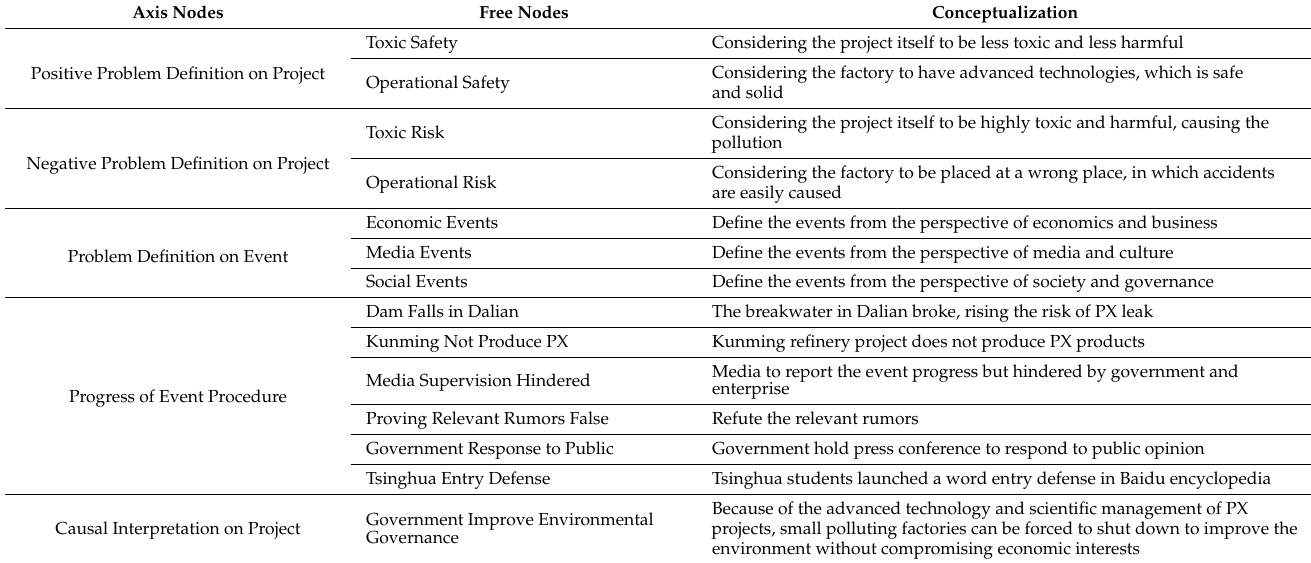
Table 3. The definition of axis nodes and free nodes in axial